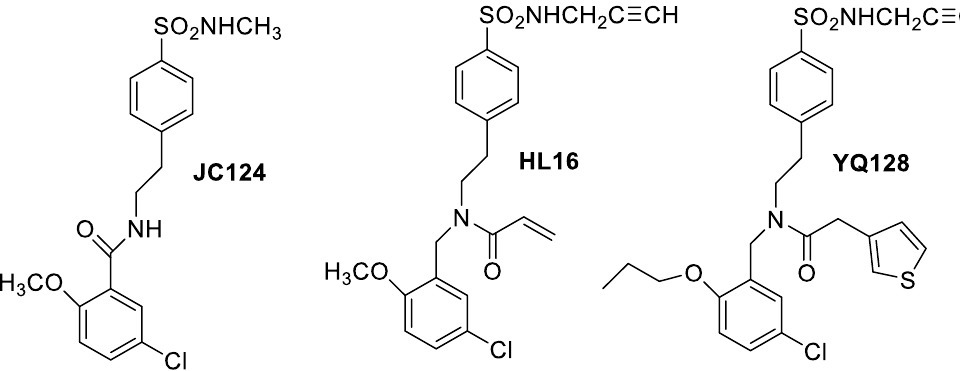
Figure 2. Modification of JC124 used for the design of the new scaffold HL16 that led to the new selective lead selective lead YQ128.